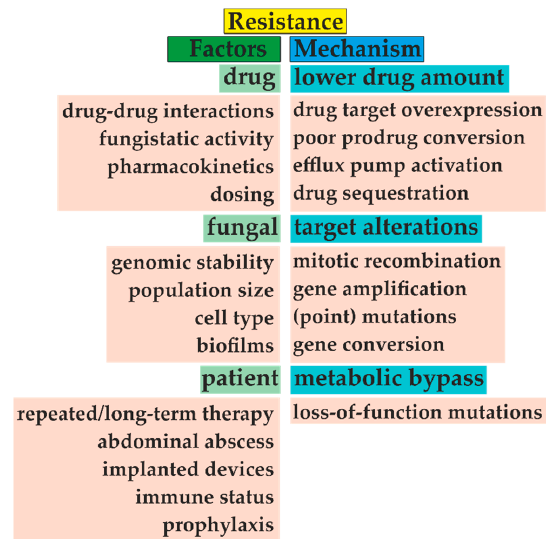
Figure 6. The emergence of microbial resistance is given by three main factors, including choice of antifungal treatment, type of fungal species, and patient medical history. For example, adequate dosing and distinguishing between fungistatic / fungicidal drug e ff ects are mandatory for successful treatment. Unfortunately, repeated antifungal therapy and often prophylaxis narrow the appropriate drug selection. With the fungal biofilm formation, this task becomes more problematic. Furthermore, fungi often decrease drug concentration by e ffl ux pump activation or target overexpression. Additionally, these targets can be amplified or changed due to several types of mutations, such as amino acid substitution. Modified from